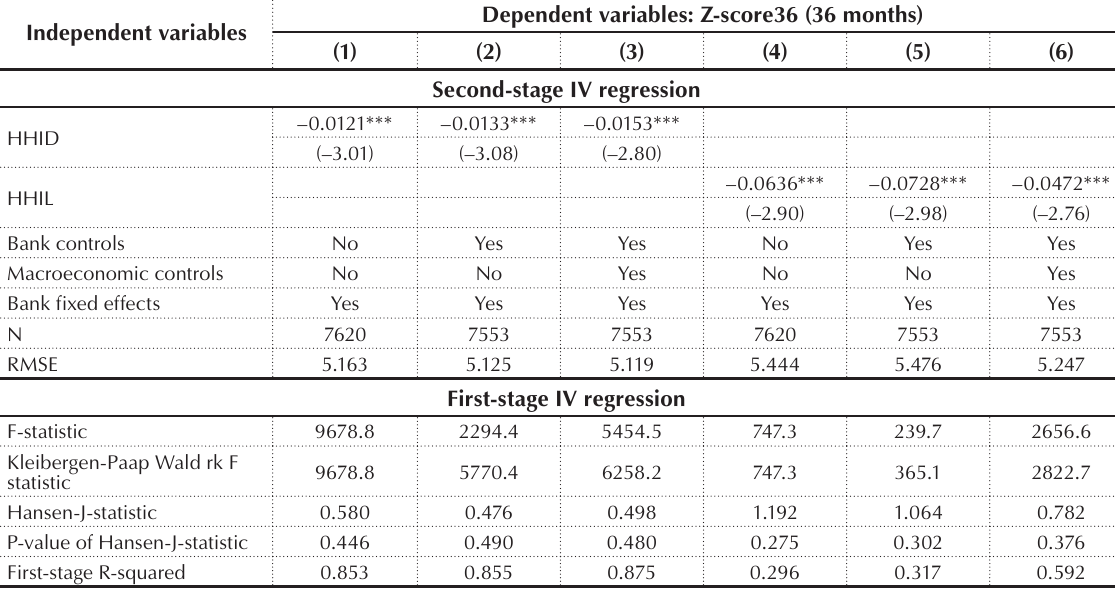
Table 4. (cid:28)(cid:374)(cid:282)(cid:381)(cid:336)(cid:286)(cid:374)(cid:286)(cid:349)(cid:410)(cid:455)(cid:3)(cid:884)(cid:3)(cid:47)(cid:115)(cid:3)(cid:396)(cid:286)(cid:336)(cid:396)(cid:286)(cid:400)(cid:400)(cid:349)(cid:381)(cid:374) Independent variables